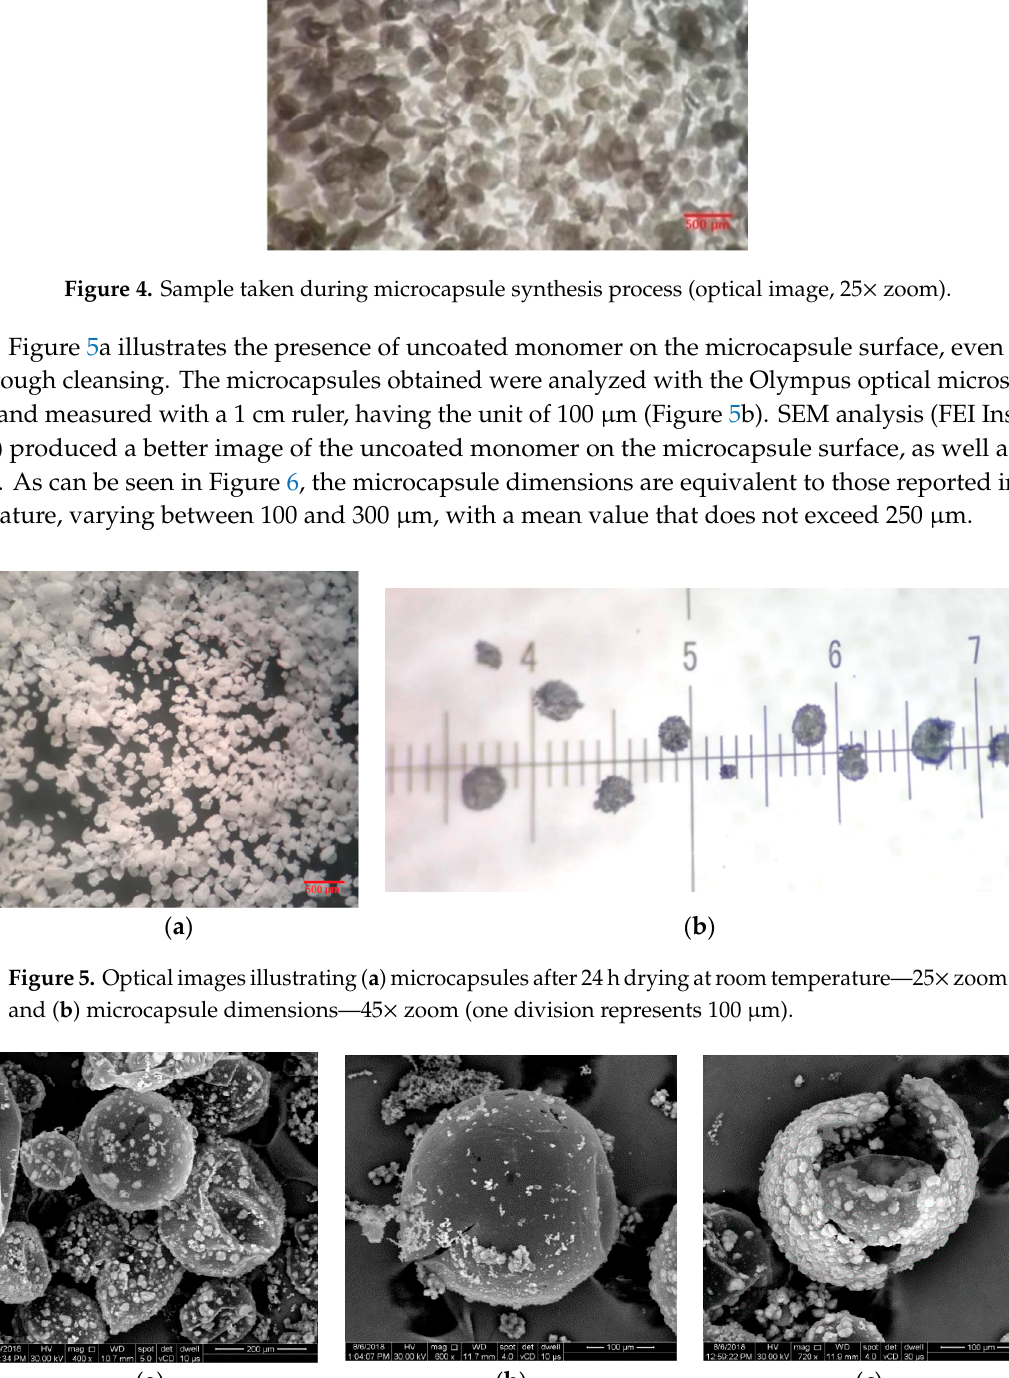
Figure 6. SEM images of ( a ) microcapsule agglomeration, ( b ) a 250 µm microcapsule, and ( c ) a broken microcapsule.